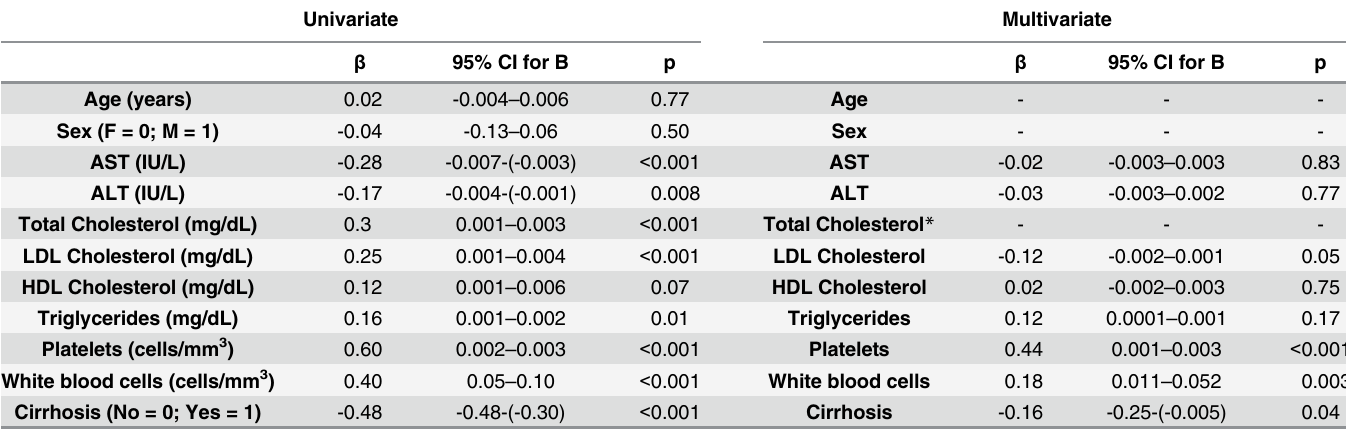
Table 4. Univariate and multivariate linear regression analysis to LAL activity in the entire study